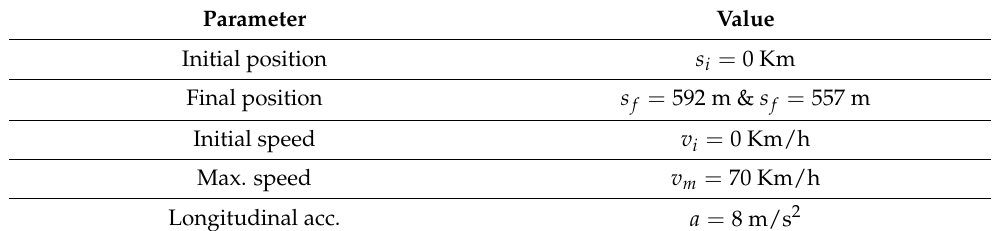
Figure 8. Vehicle tracking trajectories. Table 1. Parameters of